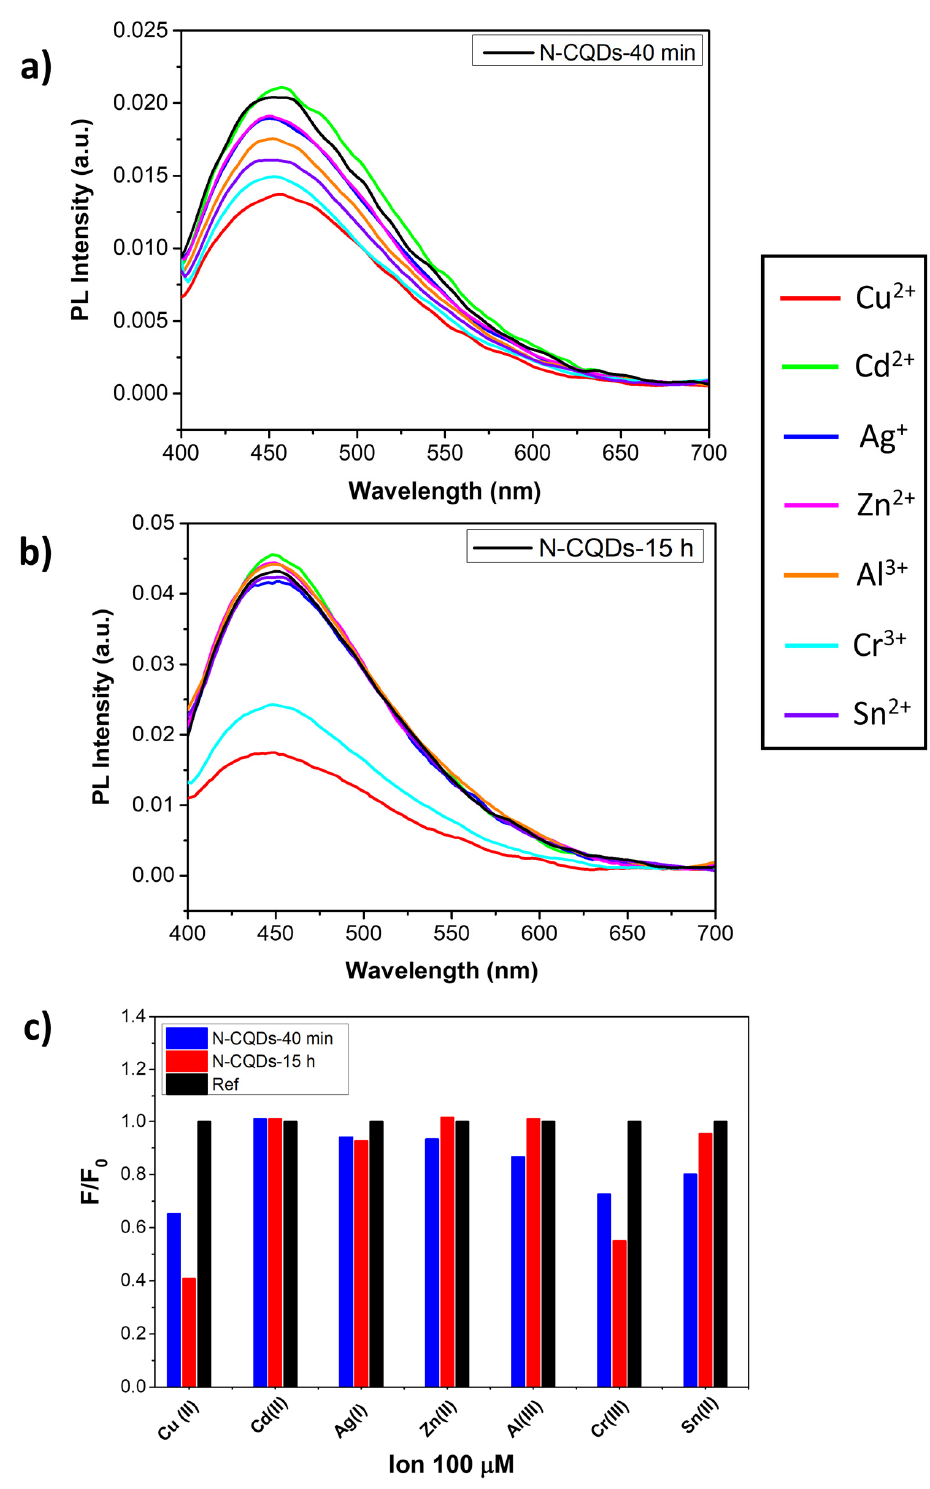
Figure 6. Photoluminescent spectra after excitation at 360 nm of ( a ) N-CQDs-40 min and ( b ) N-CQDs-15 h in the presence of different metal ions at the concentration of 100 µM. ( c ) Fluorescence quenching response of N-CQDs-40 min (blue bars) and N-CQDs-15 h (red bars) to different metal ions with the same concentration (100 µM). N-CQDs in the absence of metal ions are indicated as Ref. (black bars). The different behaviors of N-CQDs-40 min and N-CQDs-15 h with respect to Cr 3+ and Cu 2+ can be correlated with the larger presence of amine groups on N-CQDs-15 h,